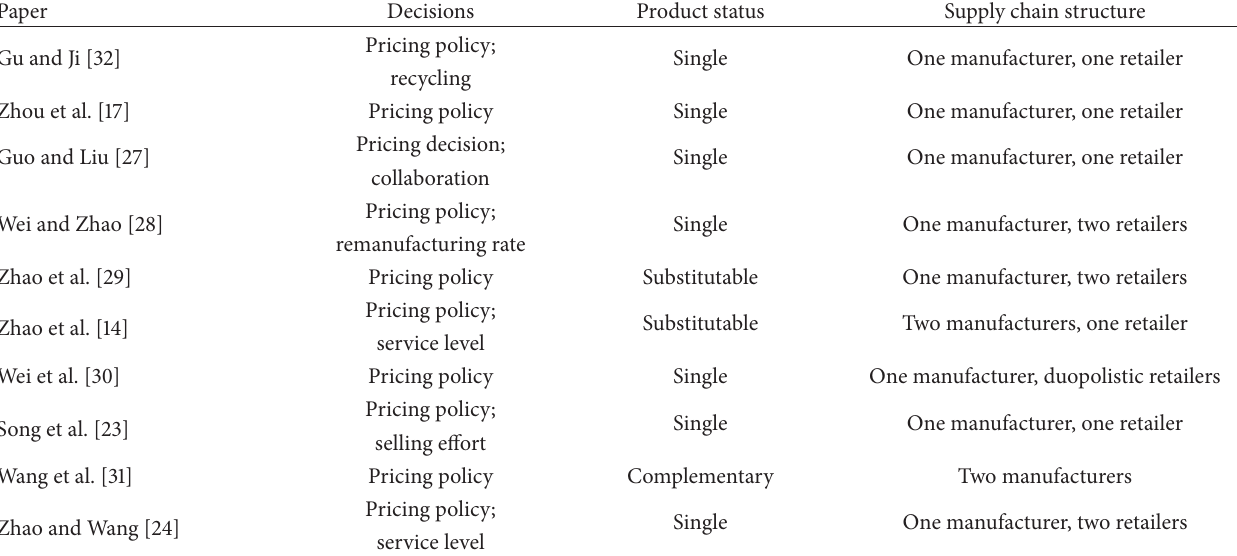
Table 1: Pricing strategies in the fuzzy